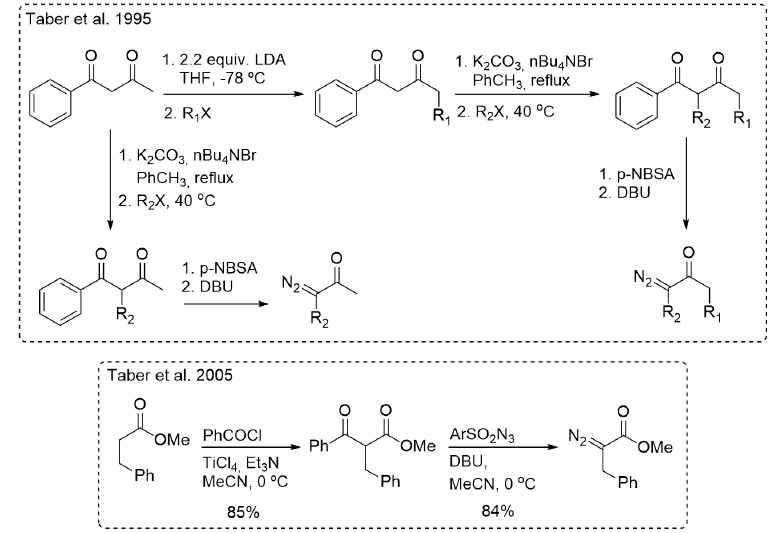
Figure 20 - Benzoylation/debenzoylation diazo transfer procedure described by Taber and